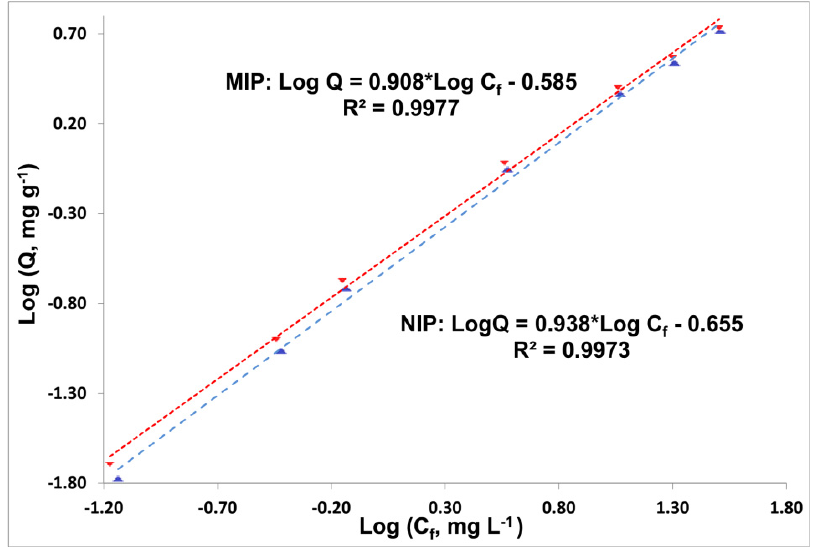
Figure 5. Phenol binding isotherms for 5 MIP and NIP (PETA) in log–log format and fitting to the Freundlich binding model: MIP, NIP.